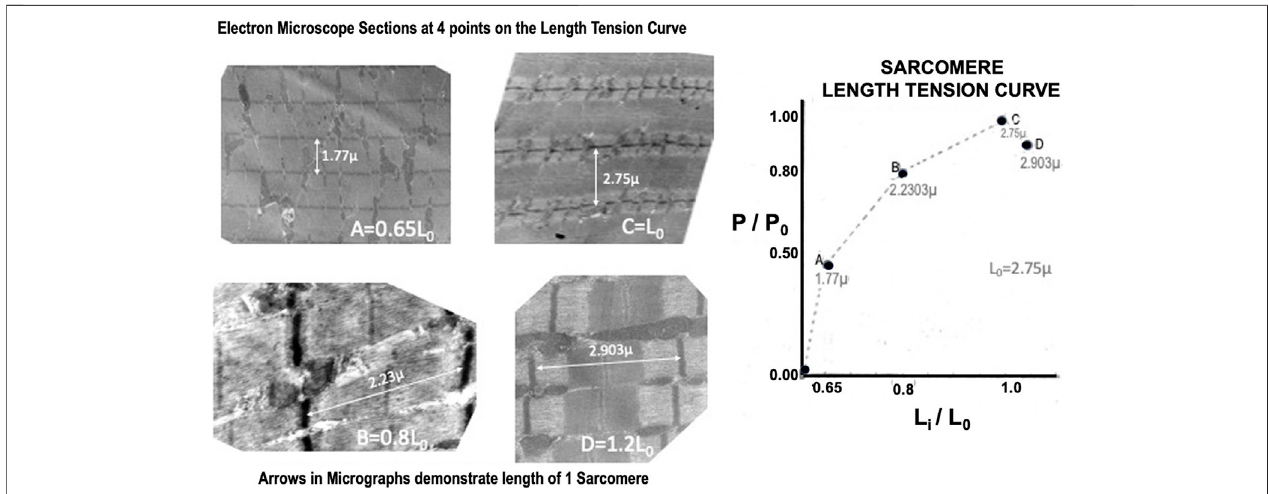
FIGURE5| Highresolutionelectronmicrographscon fi rmingthesarcomerelength:tensionrelationship.Themicrographsontheleftarefromfourmusclesthatwere fi xed at different positions on their experimental length: tension relationship.